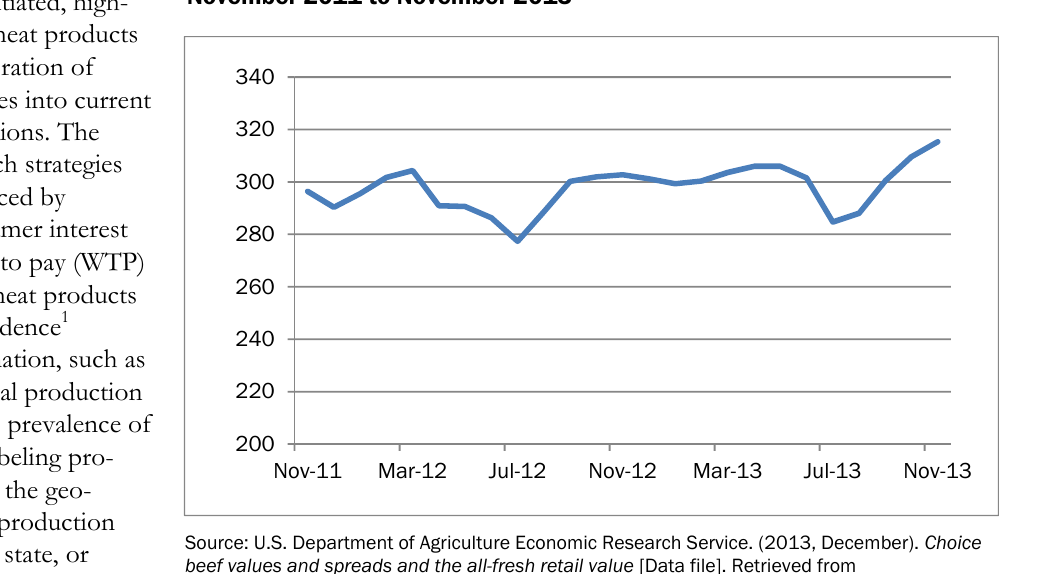
Figure 1. Choice Beef Gross Farm Value (Cents/Lb.), Monthly